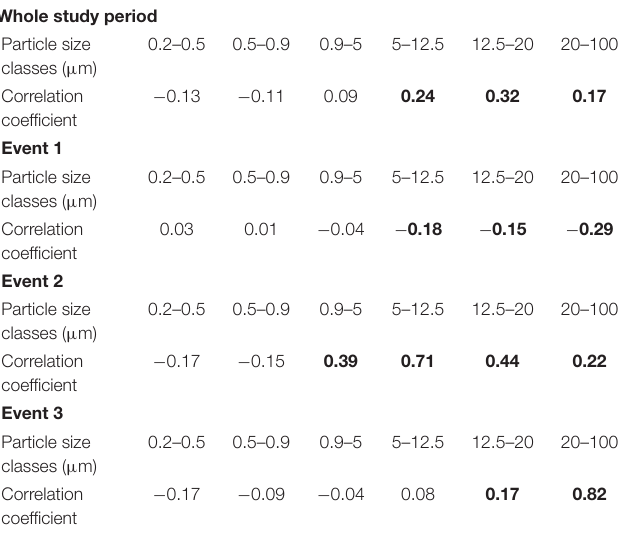
TABLE 1 | Correlation coefficients of wind speed and aerosol concentration in individual particle size classes for wind speed > 10 m s − 1 ( p < 0.02 in bold) for the whole study period and three major dust events.